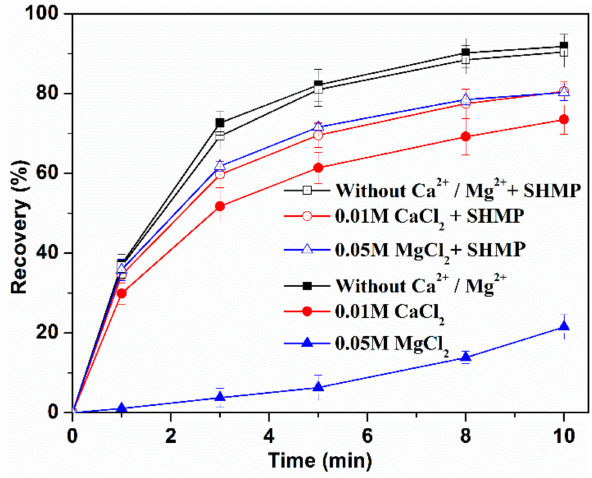
Figure 6. MoS 2 recovery at pH